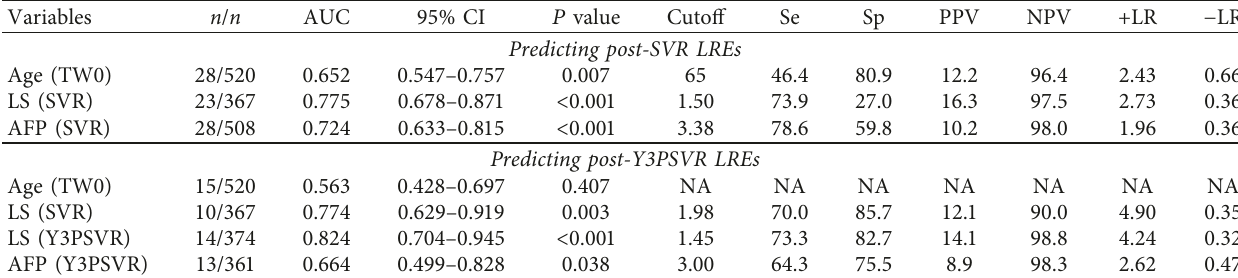
Table 5: Receiver operating characteristic analysis for the prediction of LREs after SVR and